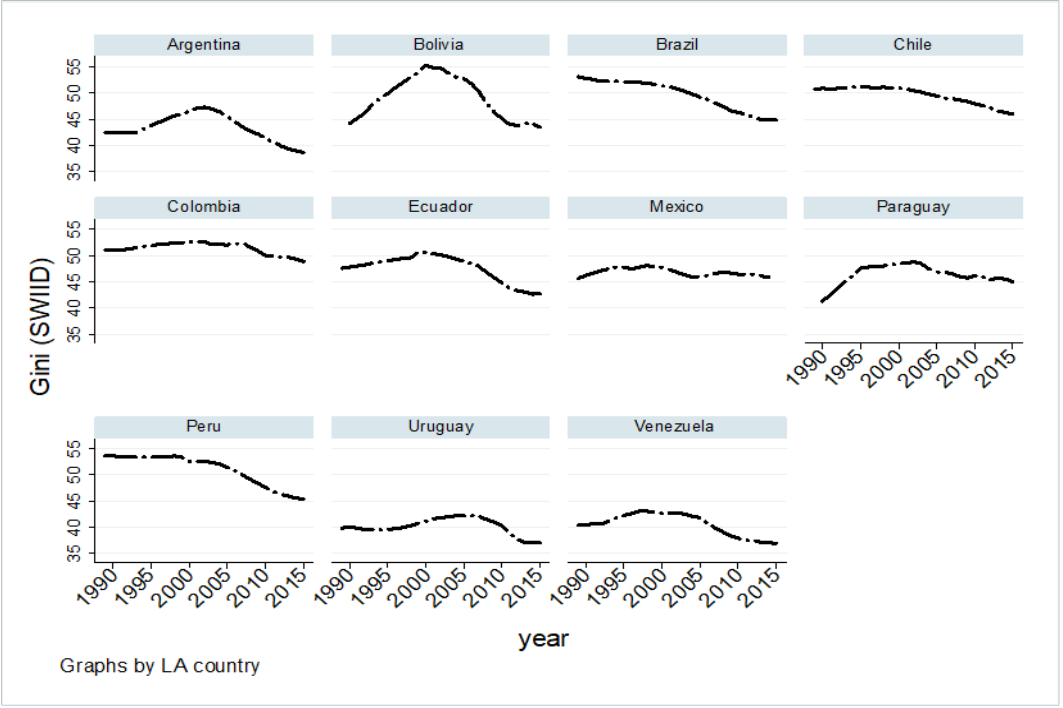
Figure 1 : The evolution of Gini